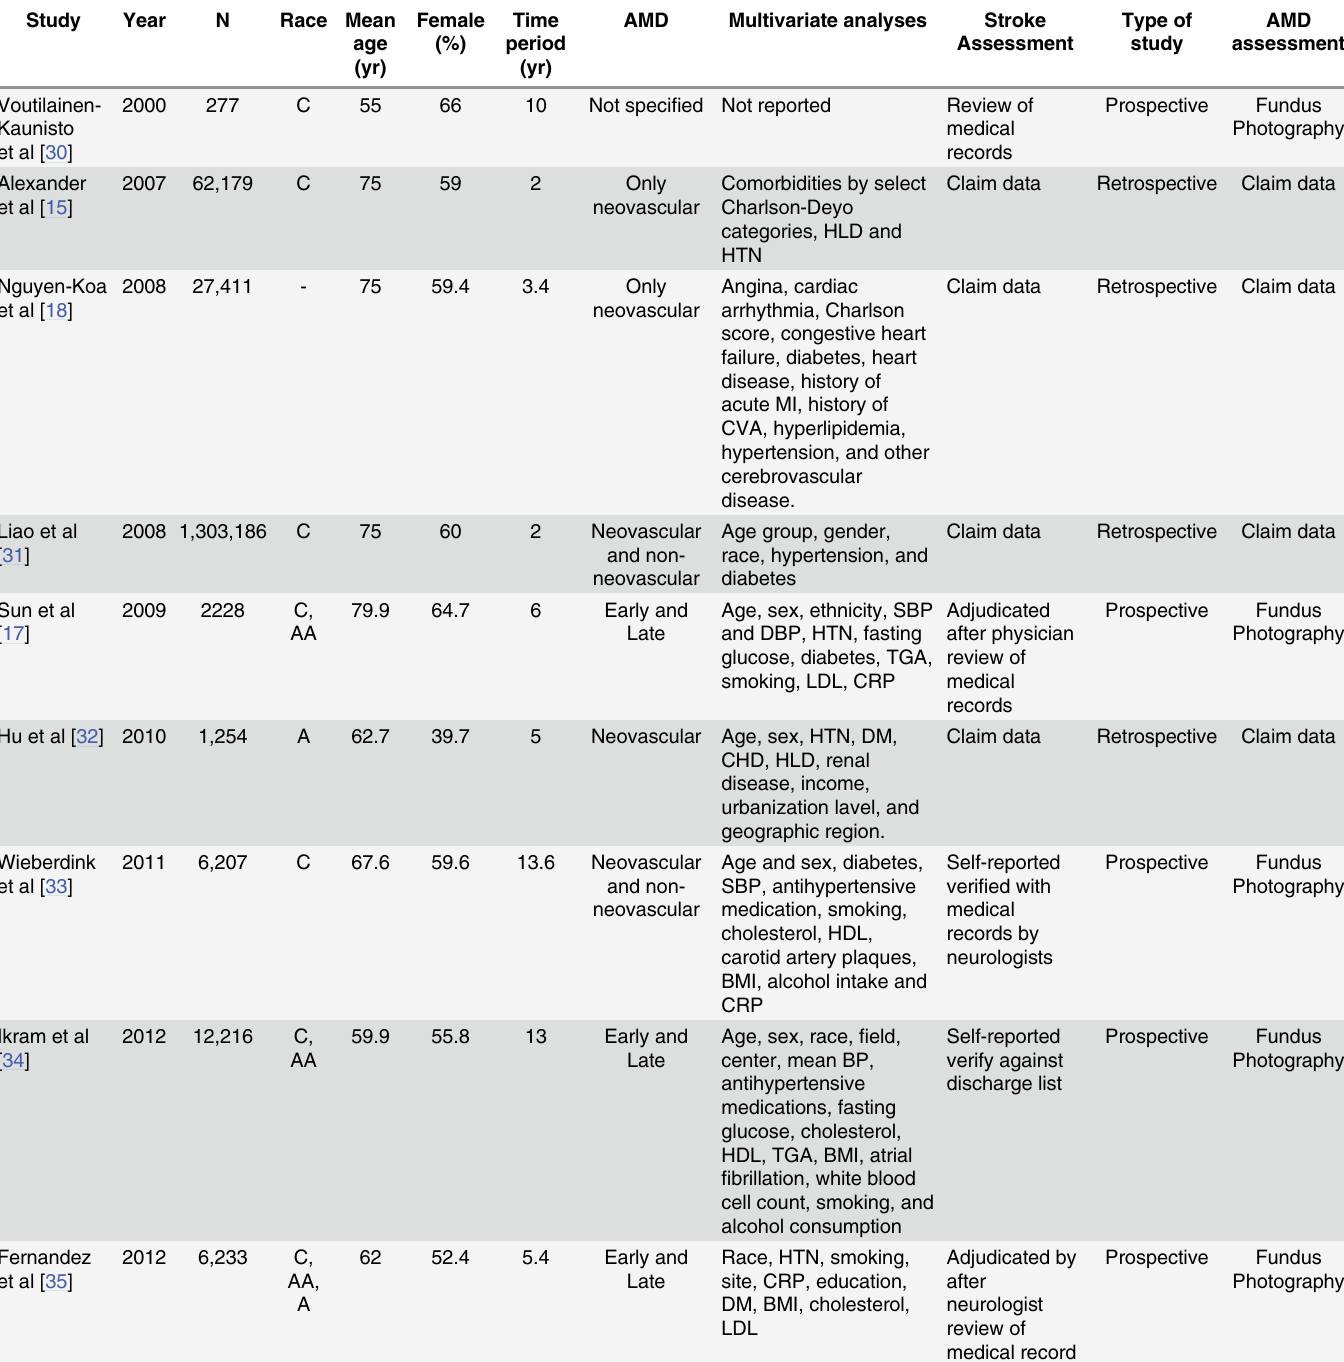
Table 1. Characteristics of included studies that evaluated the associations of AMD and risk of stroke.